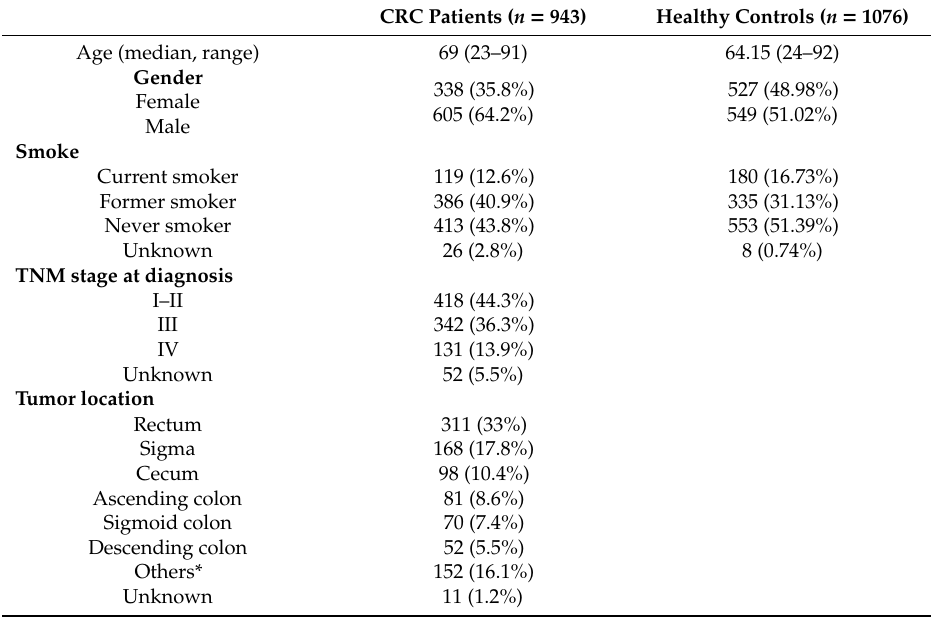
Table 1. Baseline characteristics of the patient population.